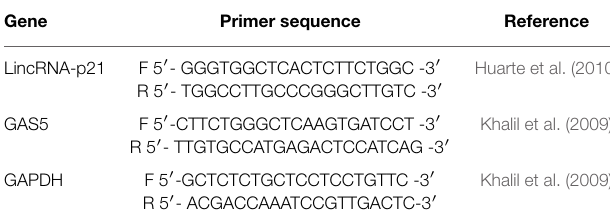
TABLE 2 | The primer sequences used in the